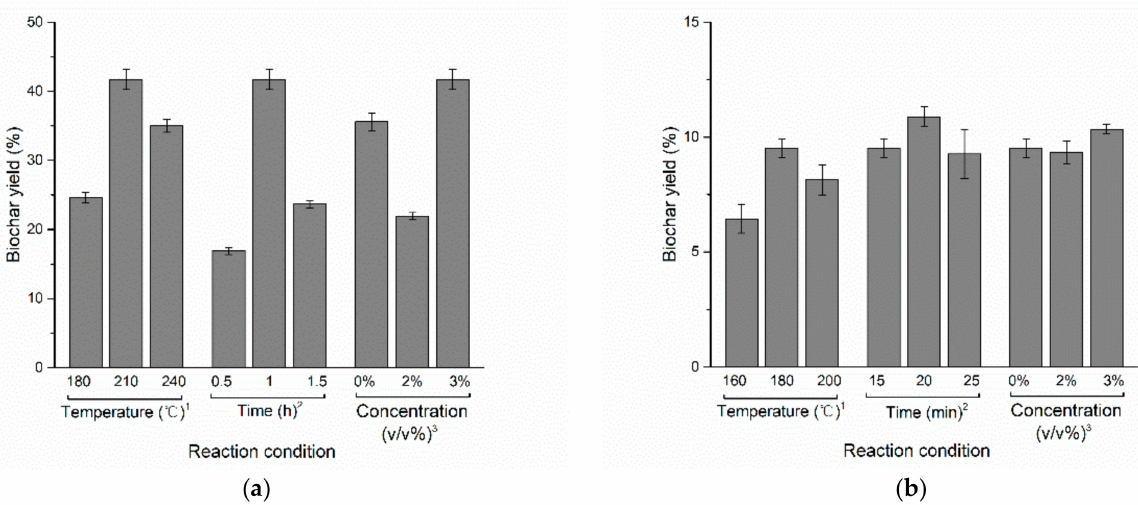
Figure 4. The yield of biochar produced from cooked rice after the HTC process. ( a ): the HTC process is performed in HPR; ( b ): the HTC process is performed in MW. Values are presented as mean ± SD from three experiments. 1 Only the reaction temperature changed in the reaction conditions. The reaction time was 1 h, and the sulfuric acid concentration was 3 v / v %. 2 Only the reaction time changed in the reaction conditions. The reaction temperature was 210 ◦ C/180 ◦ C, respectively, and the sulfuric acid concentration was 3 v / v %. 3 Only the concentration of sulfuric acid changed in the reaction conditions. The reaction temperature was 210 ◦ C/180 ◦ C, respectively, and the reaction time was 1